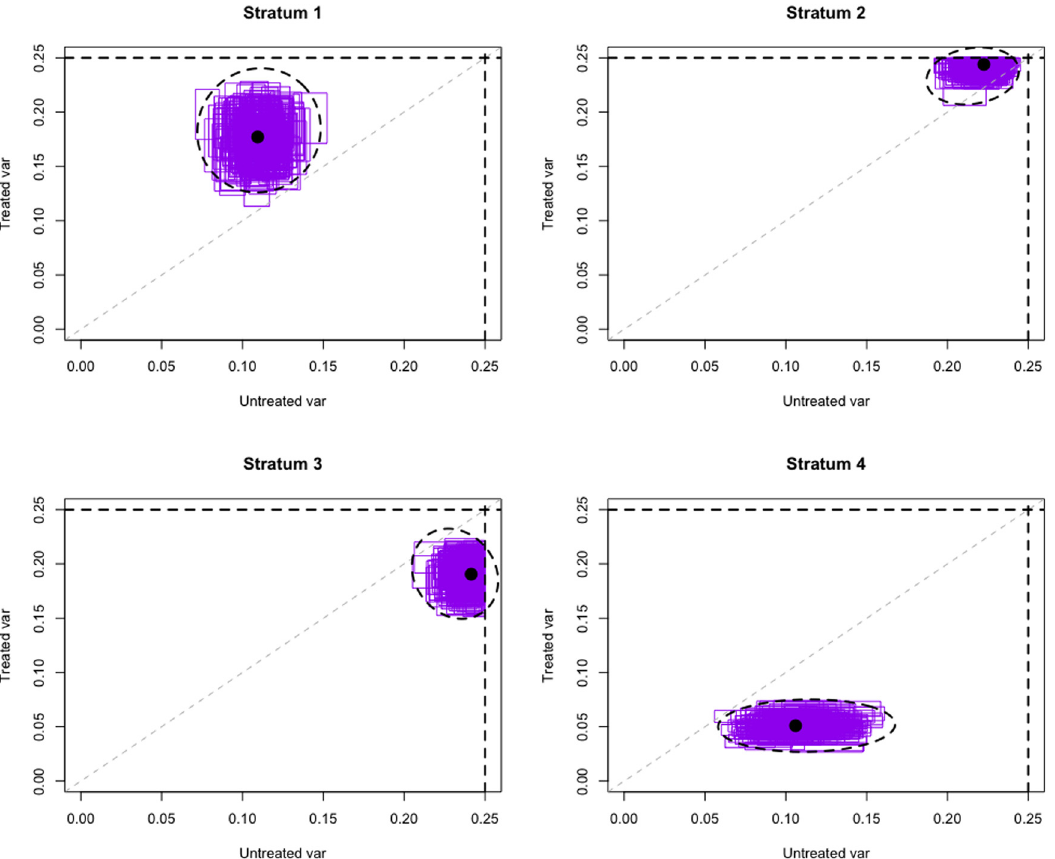
Figure 1: Simulated example of con fi dence regions in four strata under Γ 1.2 =